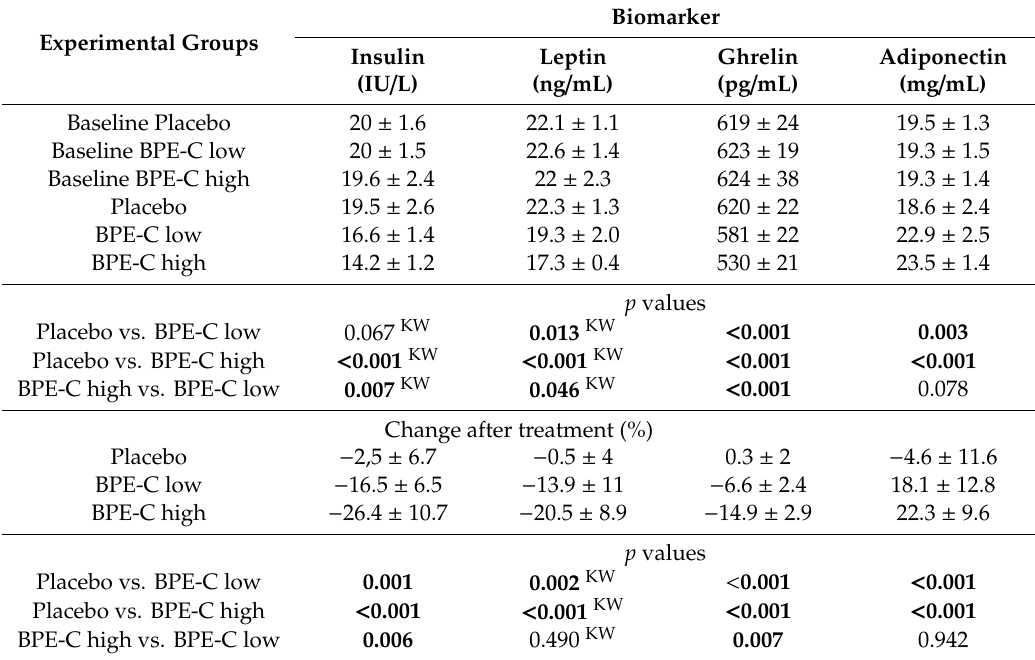
Table 2. Plasma levels of energy balance hormones and insulin, before (baseline) and after 90 days intervention on MetS patients assigned to three experimental groups (Placebo, BPE-C low and